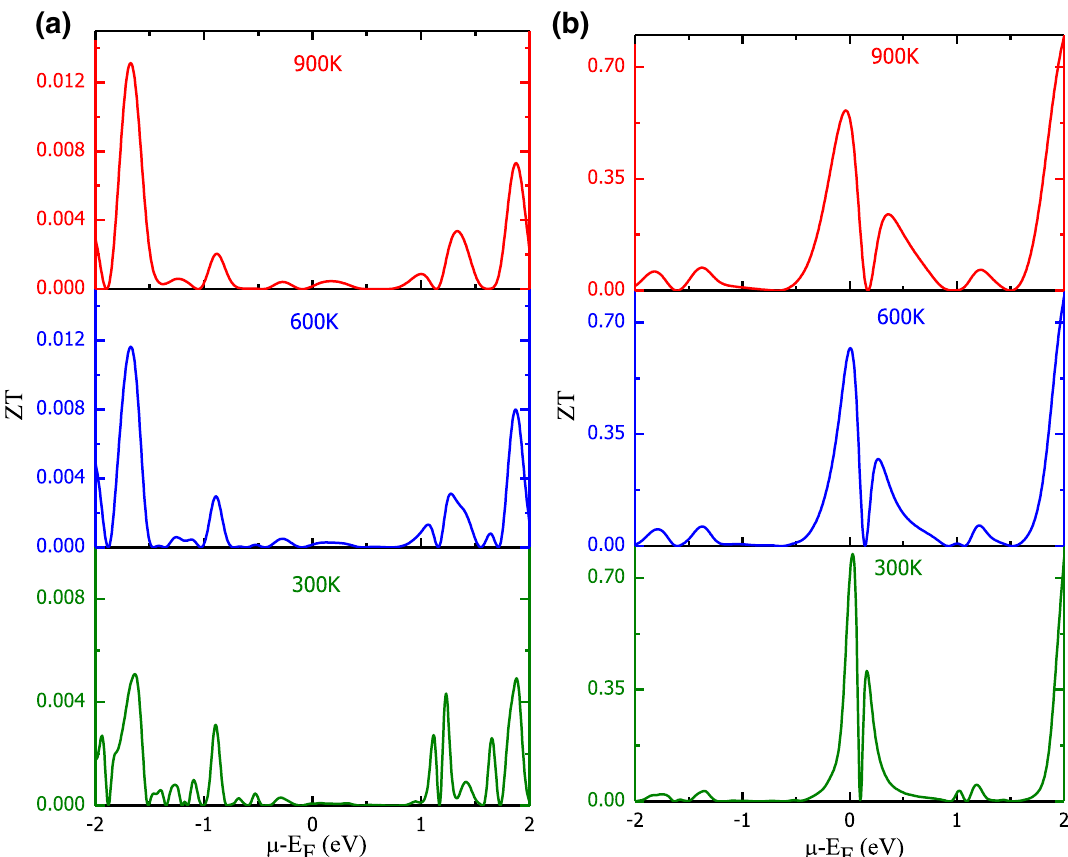
Figure 10. Behaviour of ZT without accounting lattice thermal conductivity with changing chemical potential at different temperatures: ( a ) Ba 2 FeNiO 6 ; ( b ) Ba 2 CoNiO 6